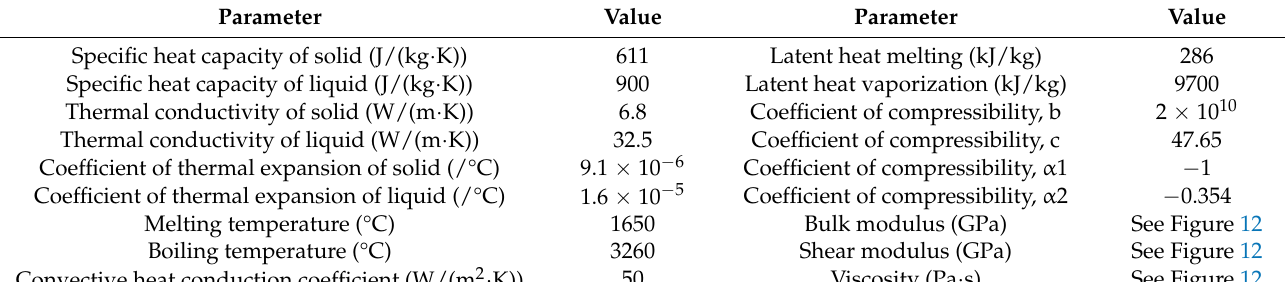
Figure 11. The discrete model for the HOTM simulation. Table 2. Material parameters of Ti–6Al–4V for the HOTM simulation.